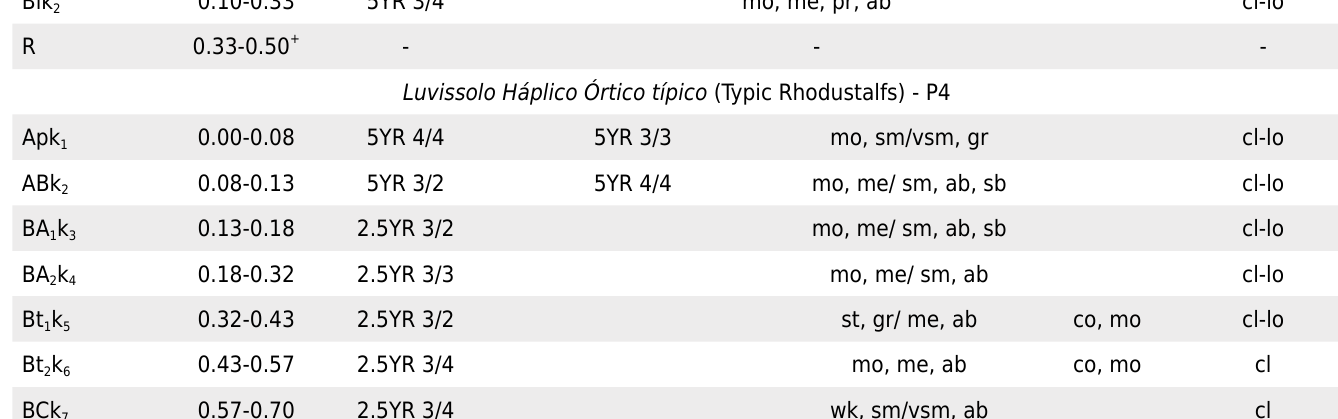
Texture class (3) Wet